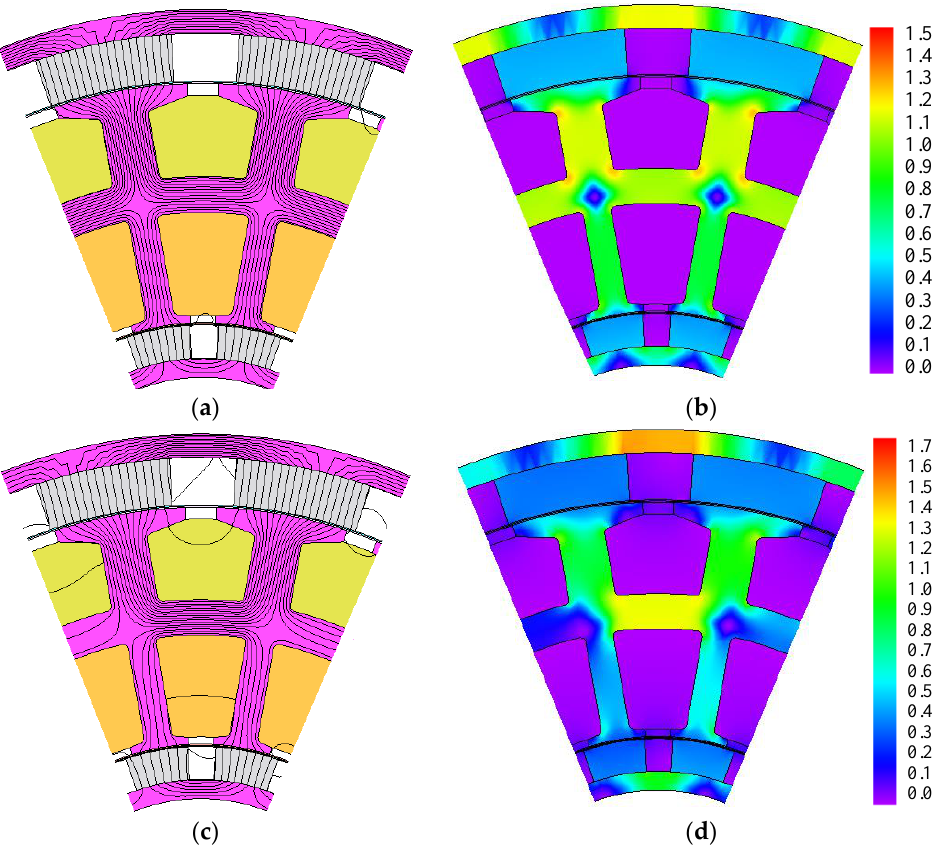
Figure 6. Flux line distribution and flux density distribution at no load and full load: ( a ) Flux line at no load; ( b ) Flux density at no load; ( c ) Flux line at full load; ( d ) Flux density at full load.